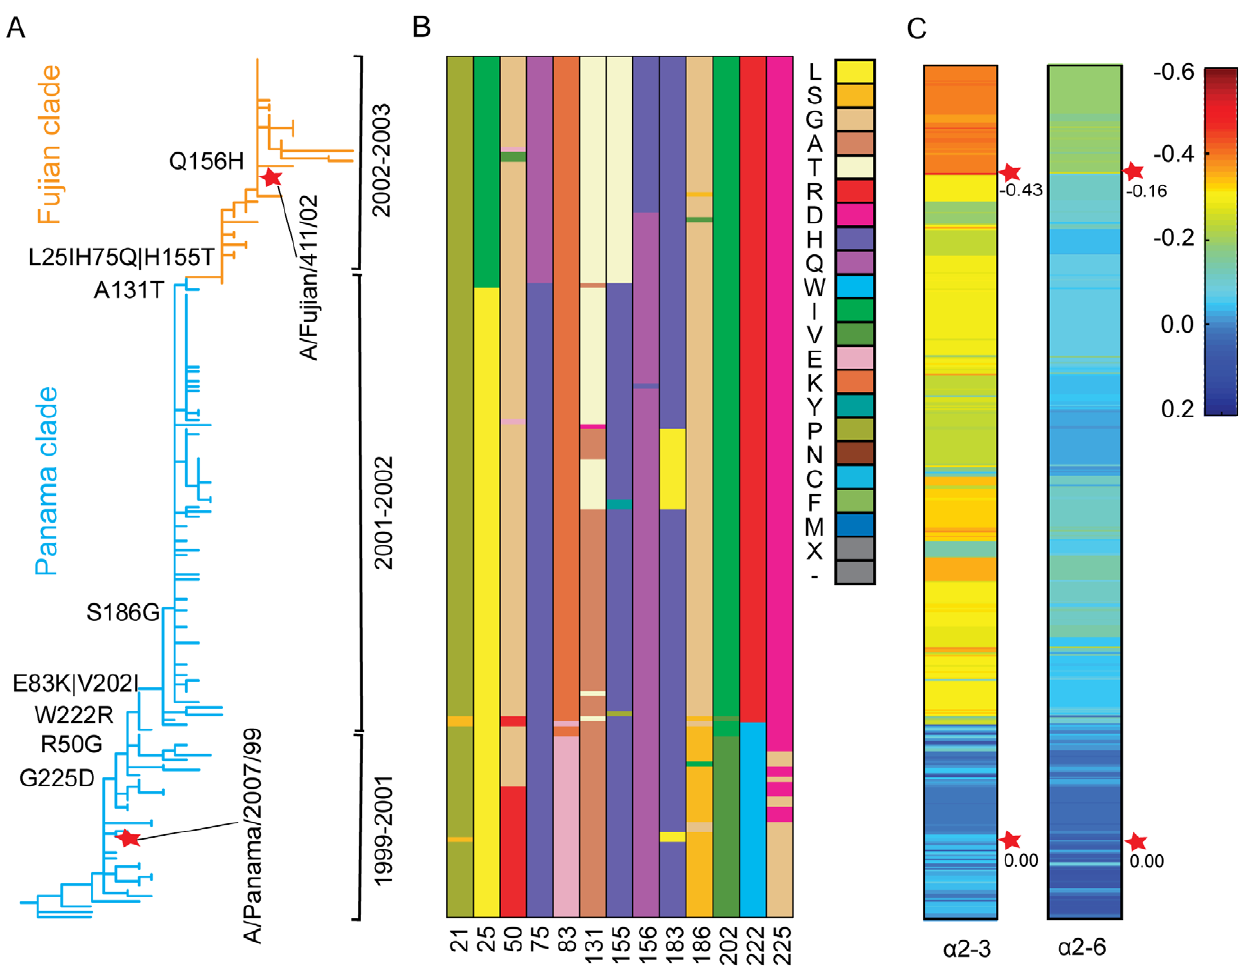
Figure 2. Evolution of receptor binding specificity of the Panama- and Fujian-like viruses. A, Phylogenetic analysis of evolutionary history of human H3N2 viruses isolated in China from year 2000 to 2002 covering flu seasons from 1999–2000 to 2002–2003. The red stars denote the position of A/Panama/2007/1999 virus and A/Fujian/411/2002 virus on the phylogenetic tree. Key amino acid changes are shown at the indicted positions during the evolution from Panama-like viruses to Fujian-like viruses. B, Dynamic changes of amino acids at 13 sites that differ between Panama-like viruses and Fujian-like viruses alined along the phylogenetic tree in A. Color code of amino acids, represented by a single letter, is shown. ‘X’ and ‘-‘ indicates unknown amino acid and gaps, respectively in the HA sequence. C, Comparison of calculated binding strengths for all HAs in A to both avian ( a 2–3) and human ( a 2–6) receptor analogs, normalized to those of HA of A/Panama/2001/99 by binding strength is aligned with the corresponding HAs in the phylogenetic tree to indicate dynamic change of the binding strengths of these viral HAs to both avian and human receptors during evolution. Scale of normalized binding strength values is shown. From year 1999 to 2003, cool colours changed to be hot colours. It reflects the binding strength was decreased, especially for the avian receptor analog. The red stars denote the normalized binding strength values of A/Panama/2007/1999 virus and A/Fujian/411/2002